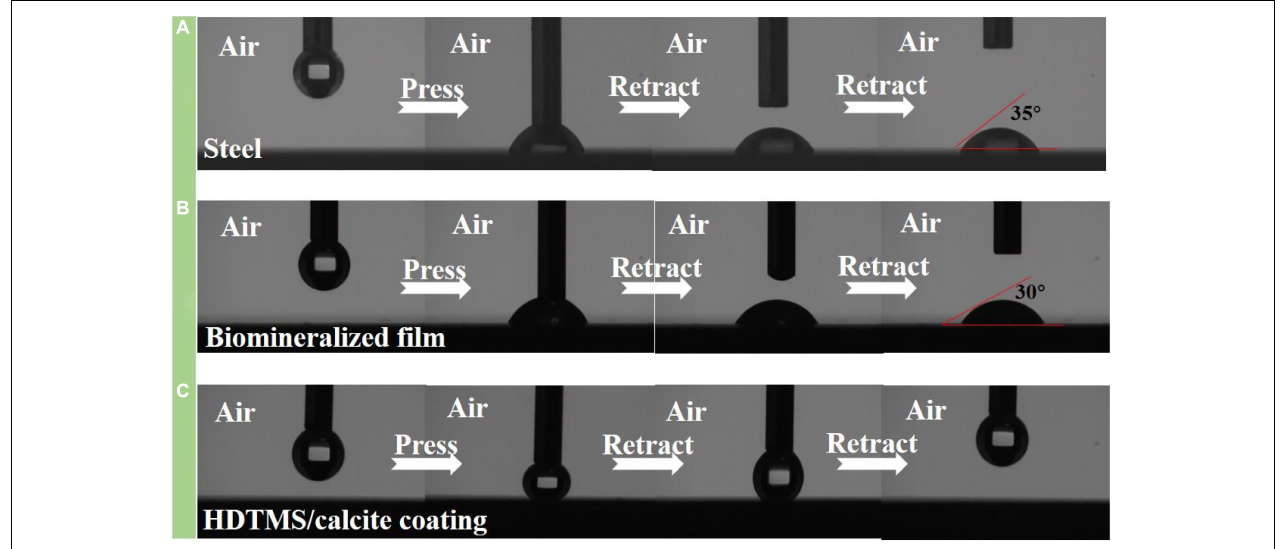
FIGURE 7 | Images of adhesion behavior of water droplets on (A) steel, (B) biomineralized film, and (C) HDTMS/calcite